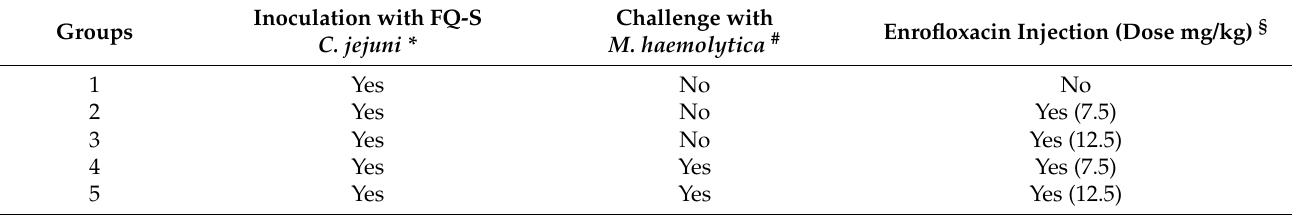
Table 1. Experimental